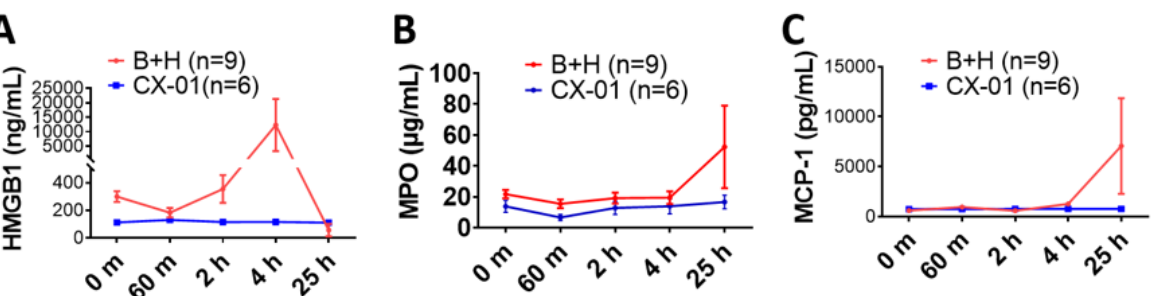
Figure 6. Effects of CX-01 treatment on cytokine concentrations in the rat model of TH. ( A ) HMGB1 plasma concentrations; ( B ) MPO plasma concentrations; and ( C ) MCP-1 plasma concentrations. Data are presented as mean ± SEM. Data were compared by using unpaired t -test with Welch’s correction, and comparison of the groups was performed two-way ANOVA. Labels: B + H = blast + hemorrhagic shock; CX-01 — treated injured rats (more details in Figure 4A).